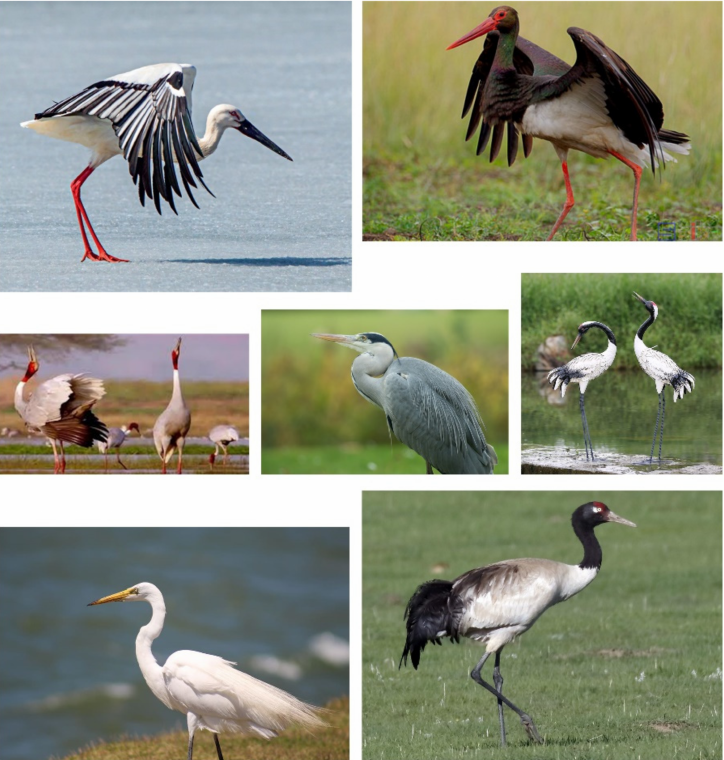
Figure 11. Practical application example of rare bird